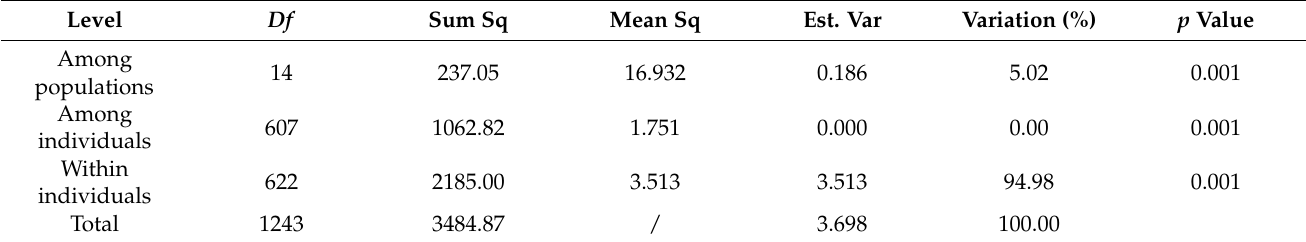
Table A2. The Analysis of Molecular Variance (AMOVA) of Pt at different levels.